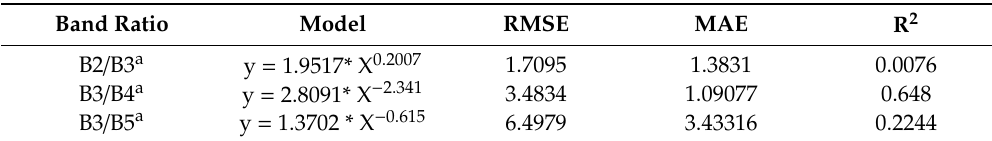
Table 7. The best-performing a(420) CDOM retrieval model estimated from the validation subset after atmospheric correction ( a ) and removal of outliers (n = 5). The variable X denotes the band ratio in the model